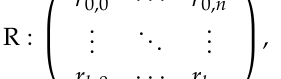
Table 2. The color hue, the sample name, and the composition as identified through the glass vials. The last two columns indicate the outcome of the portable BRAVO and benchtop measurements.